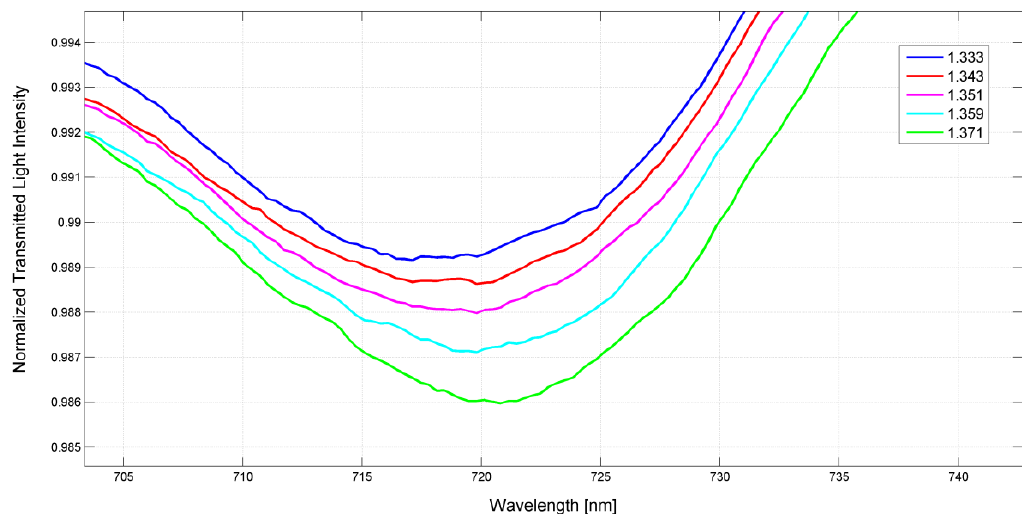
Figure 5. Experimentally obtained LSPR transmission spectra, normalized to the air spectrum, for different refractive index of the aqueous